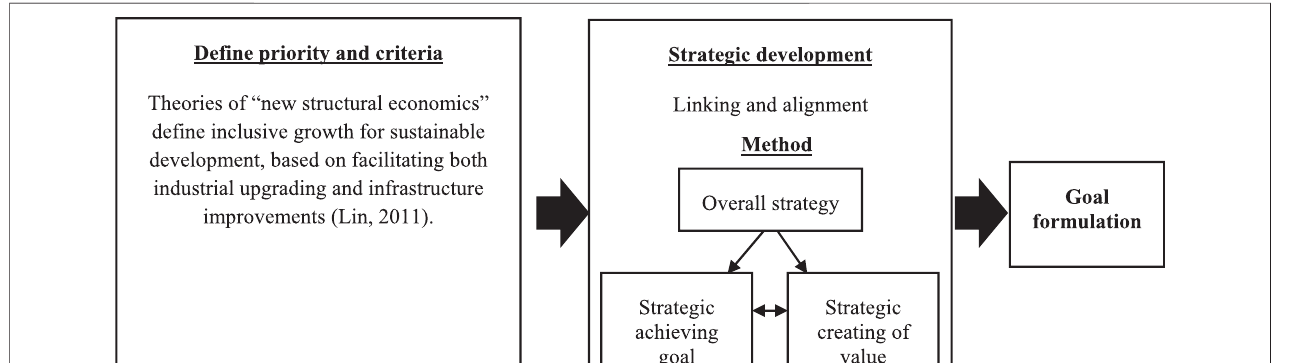
FIGURE 6 | The process of goal-setting.